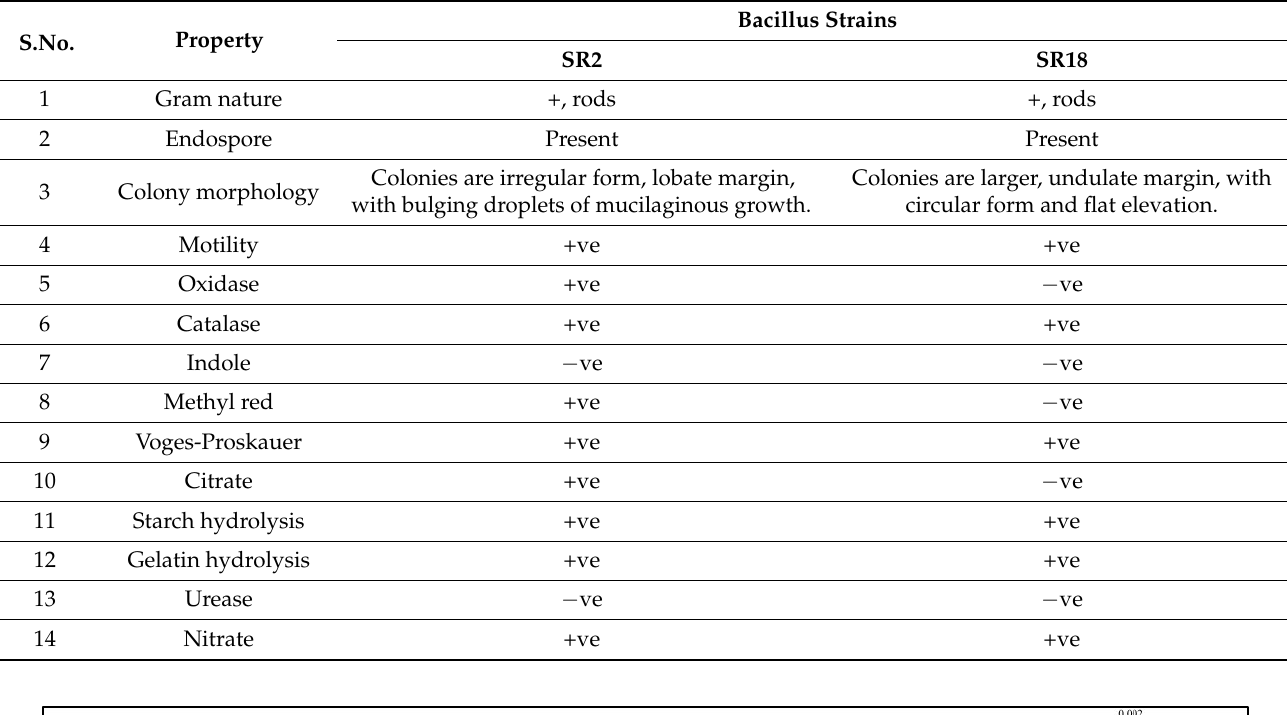
Table 2. Morphological and biochemical characteristics of potential Bacillus strains SR2 and SR18 recovered from soils of IGP region.